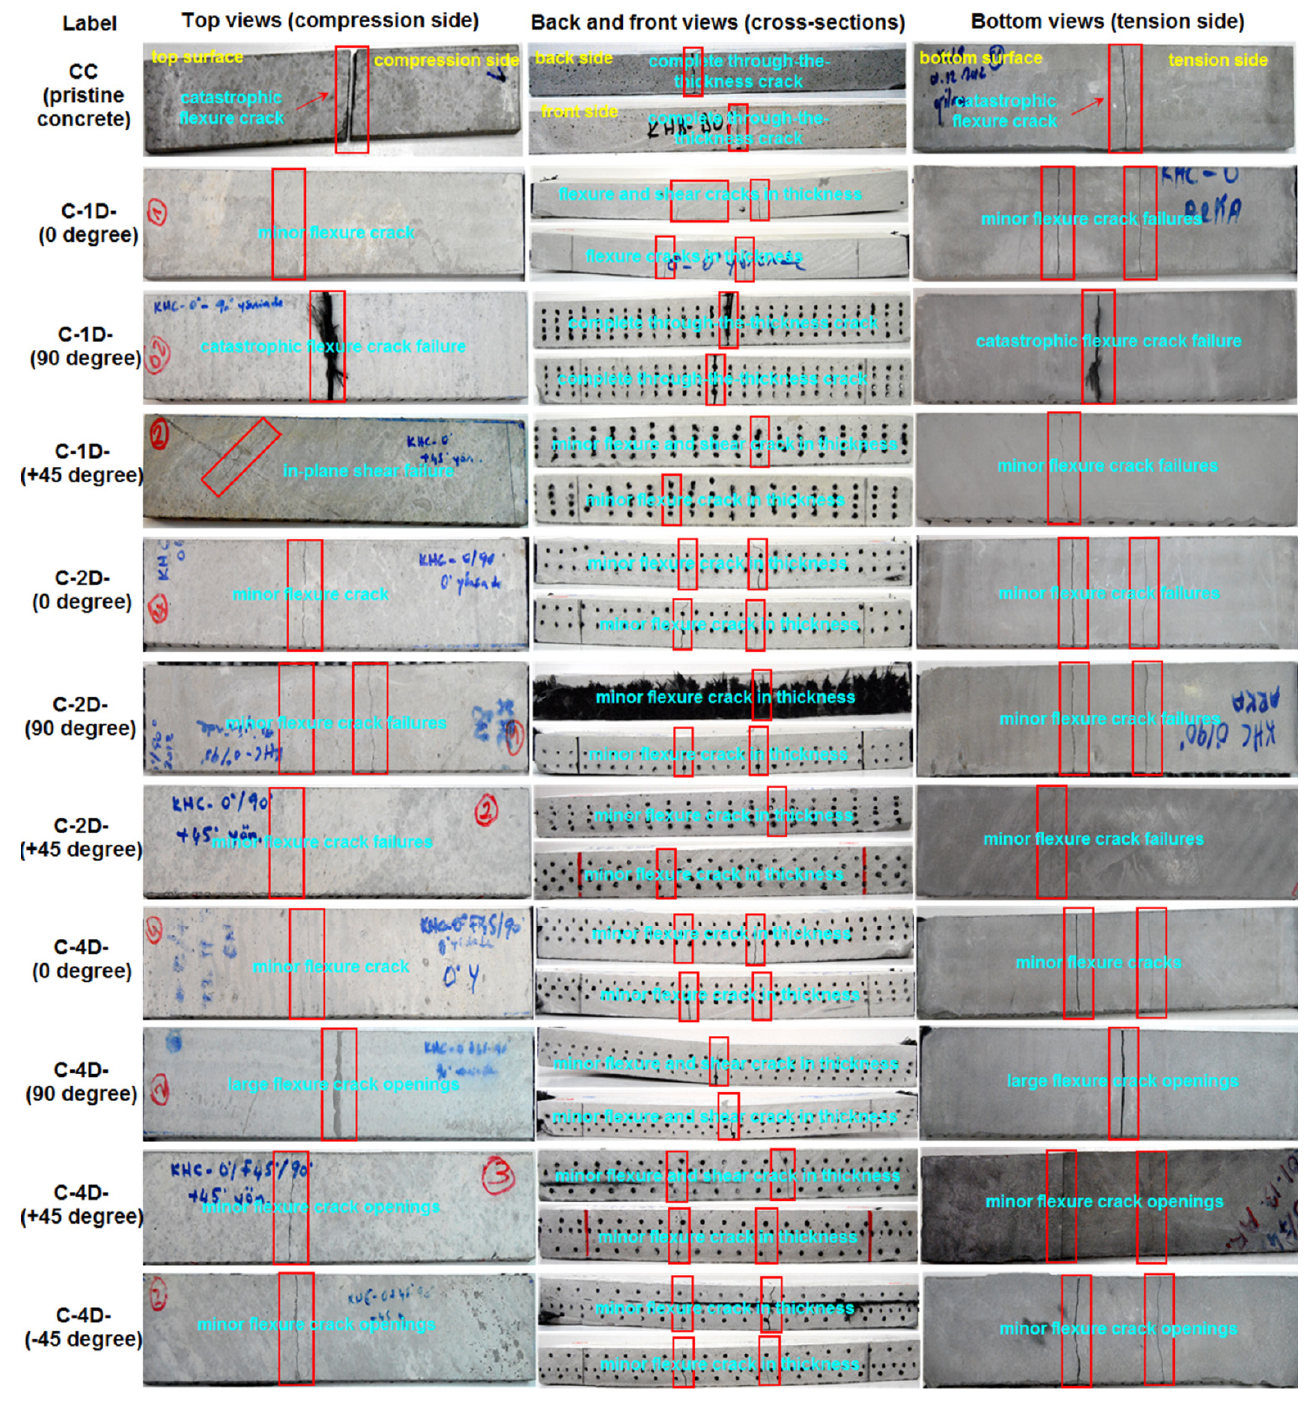
Figure 20. Various fractured multiaxis 3D carbon fibers, including the neat concretes top, bottom, cross-sections, and failure modes after the off-axis flexural test (Digital photo image).